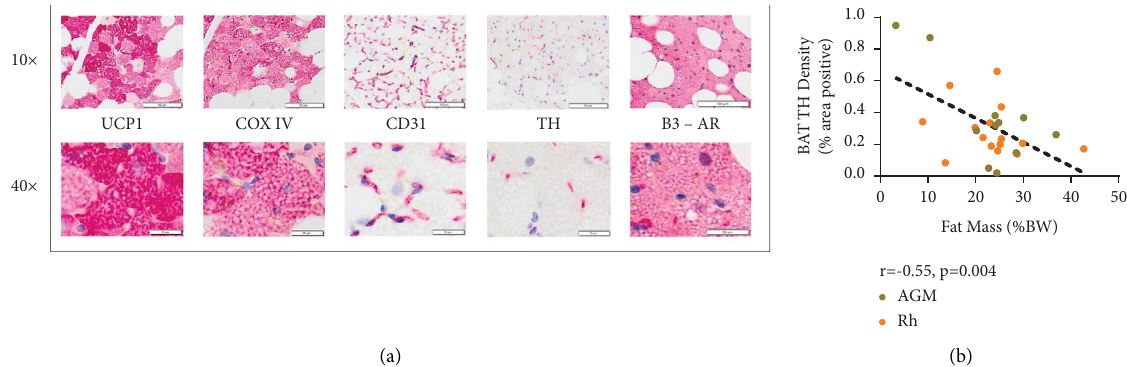
Figure 1: Immunohistochemical analysis of brown adipose tissue. Panel (a) depicts the histological features, UCP1, COX IV, CD31, TH, and β 3-AR, as expressed in brown adipose tissue from a healthy African green vervet monkey. Te immunostaining from this subject was chosen for presentation here, as this subject has the highest antibody abundance across the most histological features measured. A healthy high abundance sample was chosen to provide a clear depiction of immunostaining itself. Te top row of the panel displays samples of adipose tissue with indicated antibodies at 10x magnifcation, and the bottom row displays a portion of the same region of interest at 40x magnifcation. Te graphic on panel (b) illustrates the signifcant correlation between brown adipose tissue tyrosine hydroxylase (TH) density and fat mass expressed as a percentage of body weight ( p value � 0.004, r �− 0.55, n � 26).